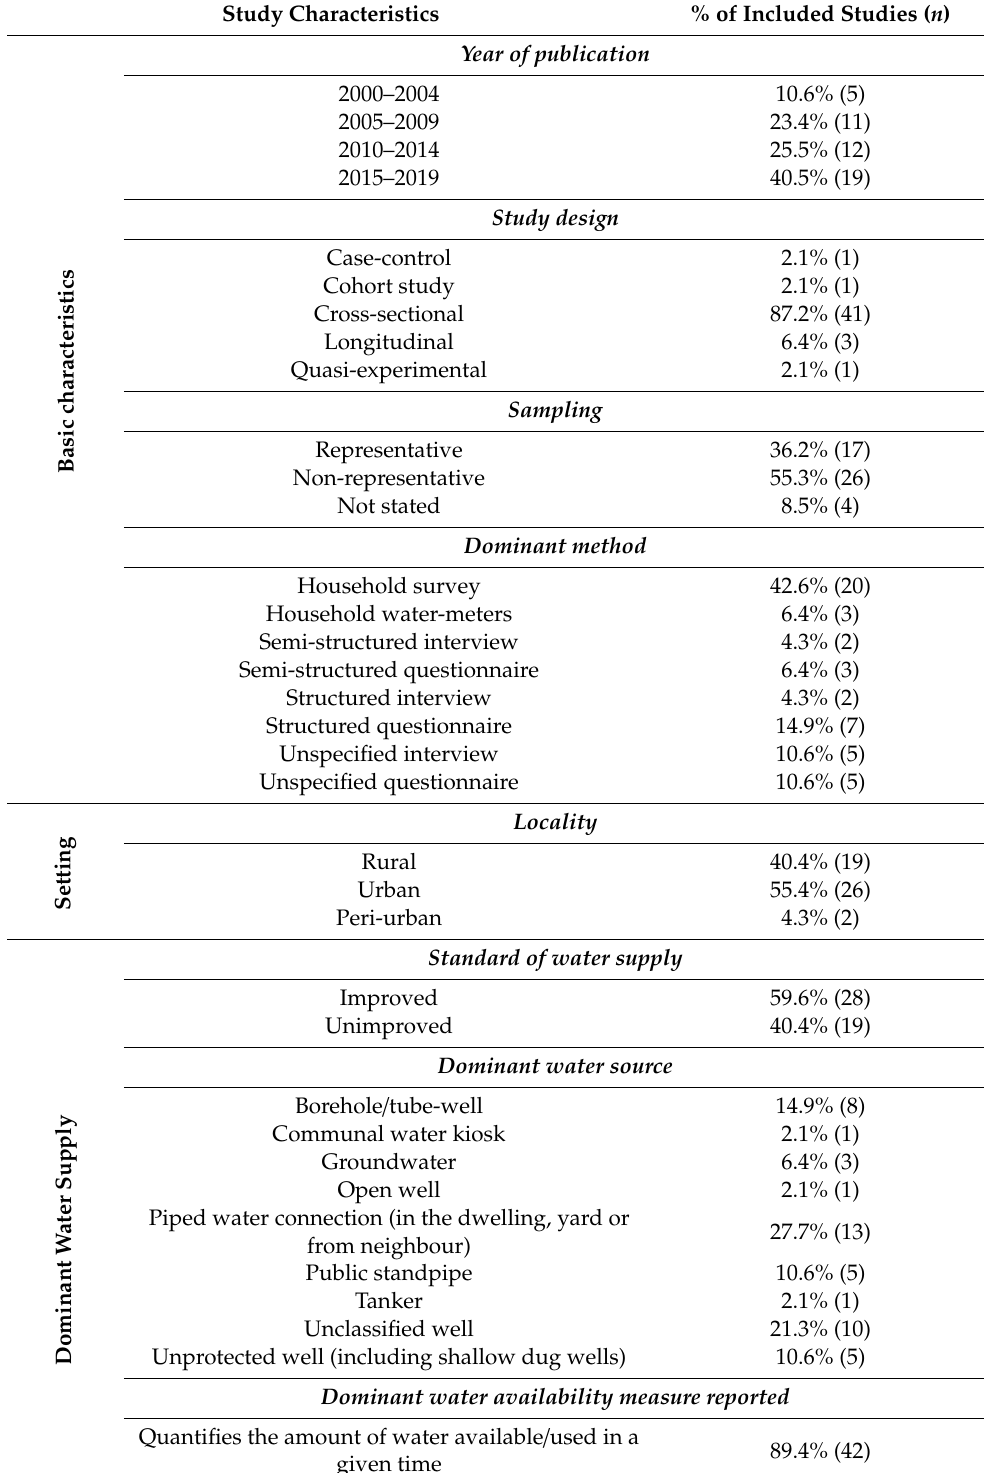
Table 4. Characteristics of included